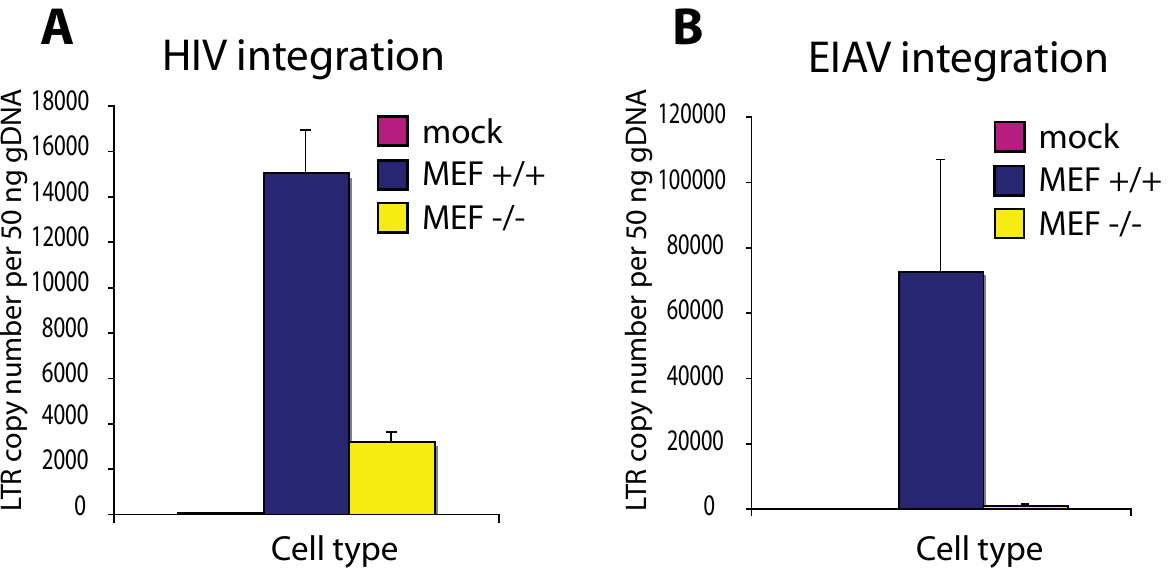
Figure 2. Efficiency of lentiviral infection in control ( + / + ) and homozygous LEDGF/p75-disrupted ( 2 / 2 ) murine cells, measured by quantitative PCR. A) HIV infectivity. B) EIAV infectivity.